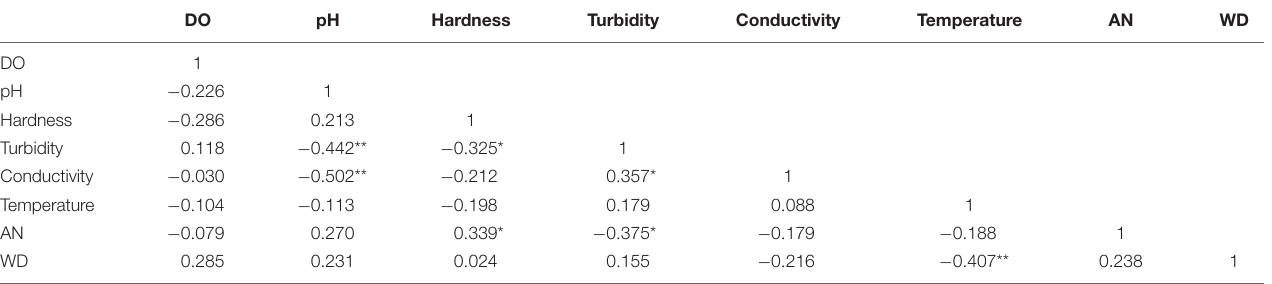
TABLE 3 | Correlation between variables with physicochemical property.